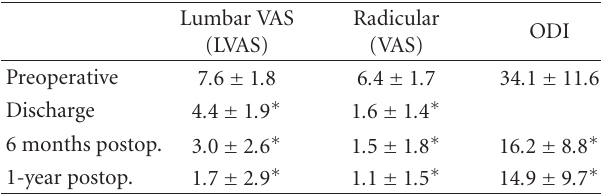
Table 2: Means LVAS, RVAS, and ODI scores at preoperative, discharge, 6 months and 1-year postoperative.